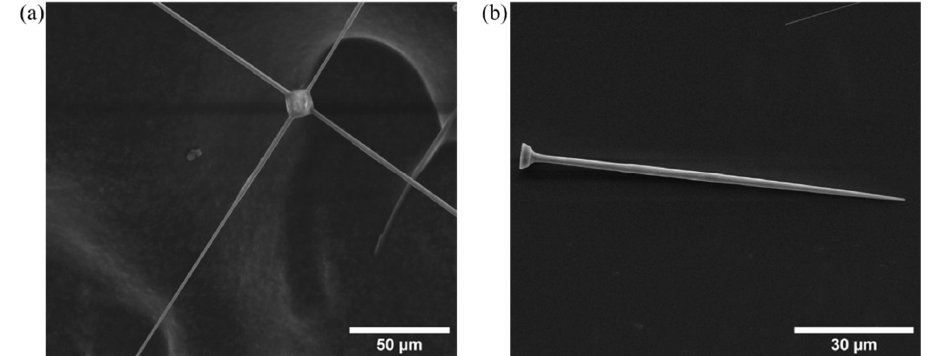
Figure 2. SEM images of the structures with different morphologies: ( a ) long tapered rods growing from a central ball and ( b ) a long tapered nail.